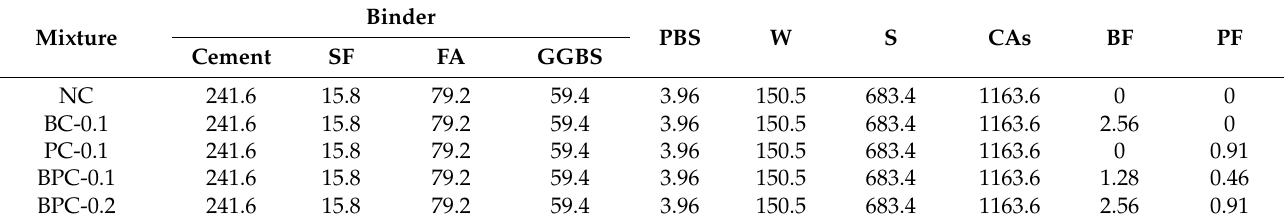
Table 3. Mix proportions of the HBPRC (kg/m 3 ).